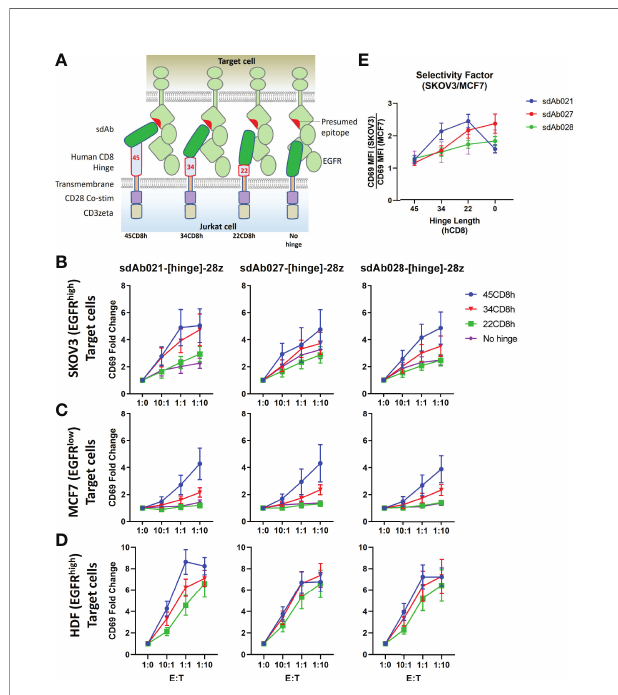
FIGURE 2 | Hinge truncation decreases target response for EGFR-sdAb CAR constructs. (A) Structure of single domain antibody based CARs targeting human EGFR were generated with hinge domains of varying length [full length human CD8-hinge (45CD8h), truncated CD8-hinge (34CD8h or 22CD8h), or no hinge element. (B, C) Jurkat cells were electroporated with varying CAR plasmid constructs before co-incubation with no target cells (1:0 E:T), EGFR-high SKOV3 cells, or EGFR-low MCF7 cells. 30 000 CAR-Jurkat cells were incubated overnight with varying numbers of target cells before CAR/GFP+ cells were examined for activation via staining with APC-labelled anti-human CD69 antibody. (D) Shows the relative CAR-J activation of various constructs in response to SKOV3 or MCF7. Results show the mean +/- SEM from three experiments performed in